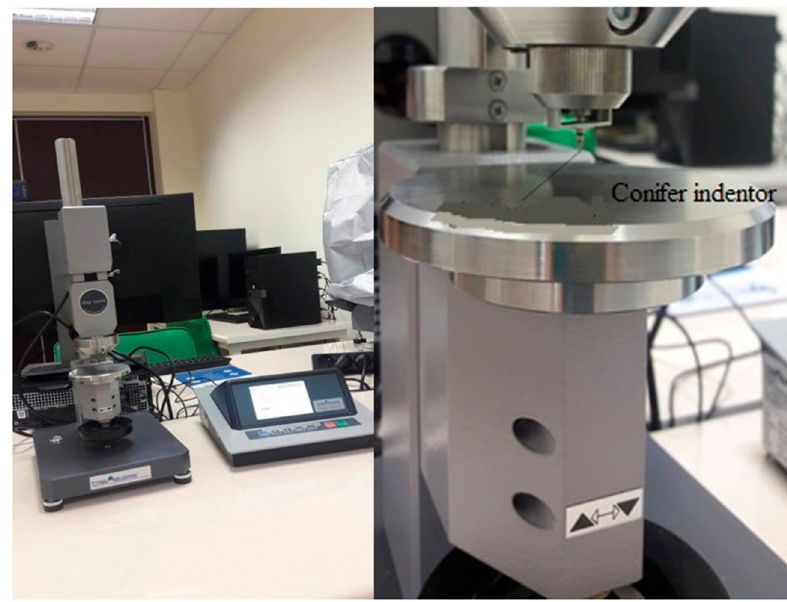
Figure 7. Shore’s hardness tester type M SHORE D/C/D0 0.5.